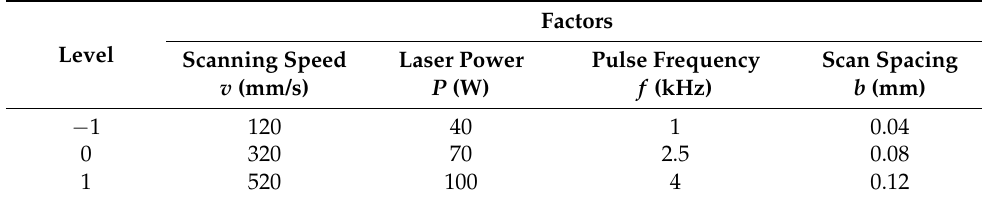
Table 2. Response surface experimental factor level table.